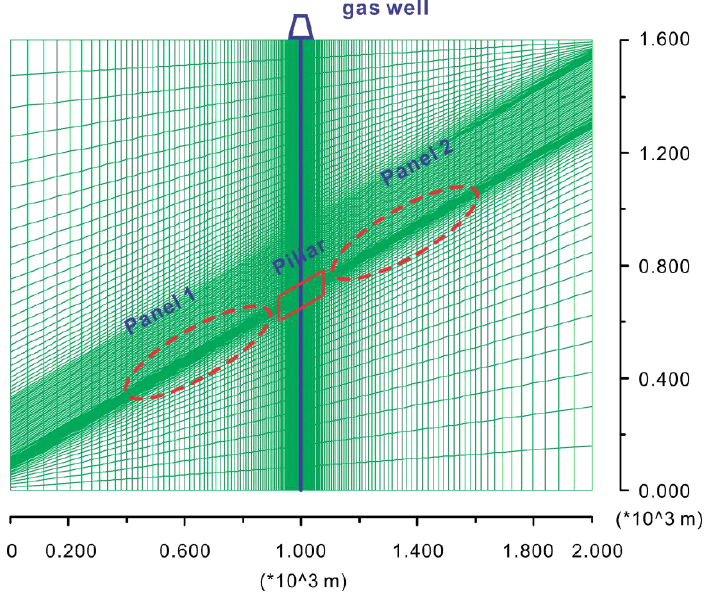
Figure 7. A FLAC model to investigate the effect of SDA on well stability (with a dip angle of 31° as an example).